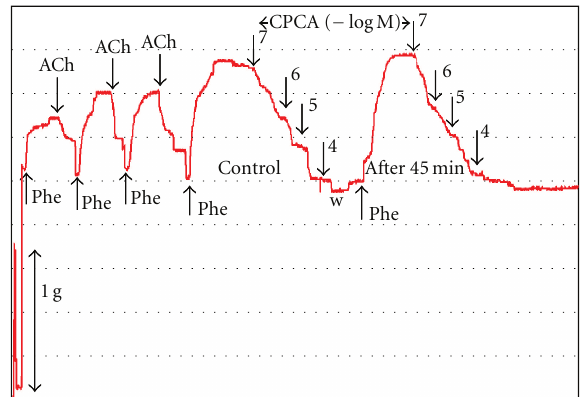
Figure 1: Original recording of CPCA-produced cumulative vascu- lar response of isolated rat femoral artery. A multiple curve design protocol was applied, since the preliminary experiments on prepa- rations of femoral artery ( n = 4) demonstrated that the first and the second concentration-response curve (determined 45 min apart) for CPCA were not significantly di ff erent. Ach: acetylcholine; Phe: